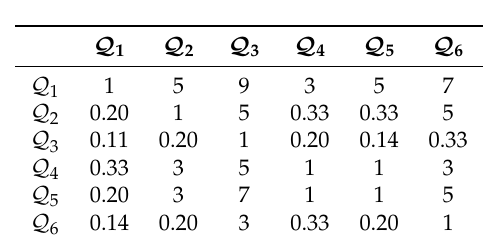
Table 3. The pairwise comparison of